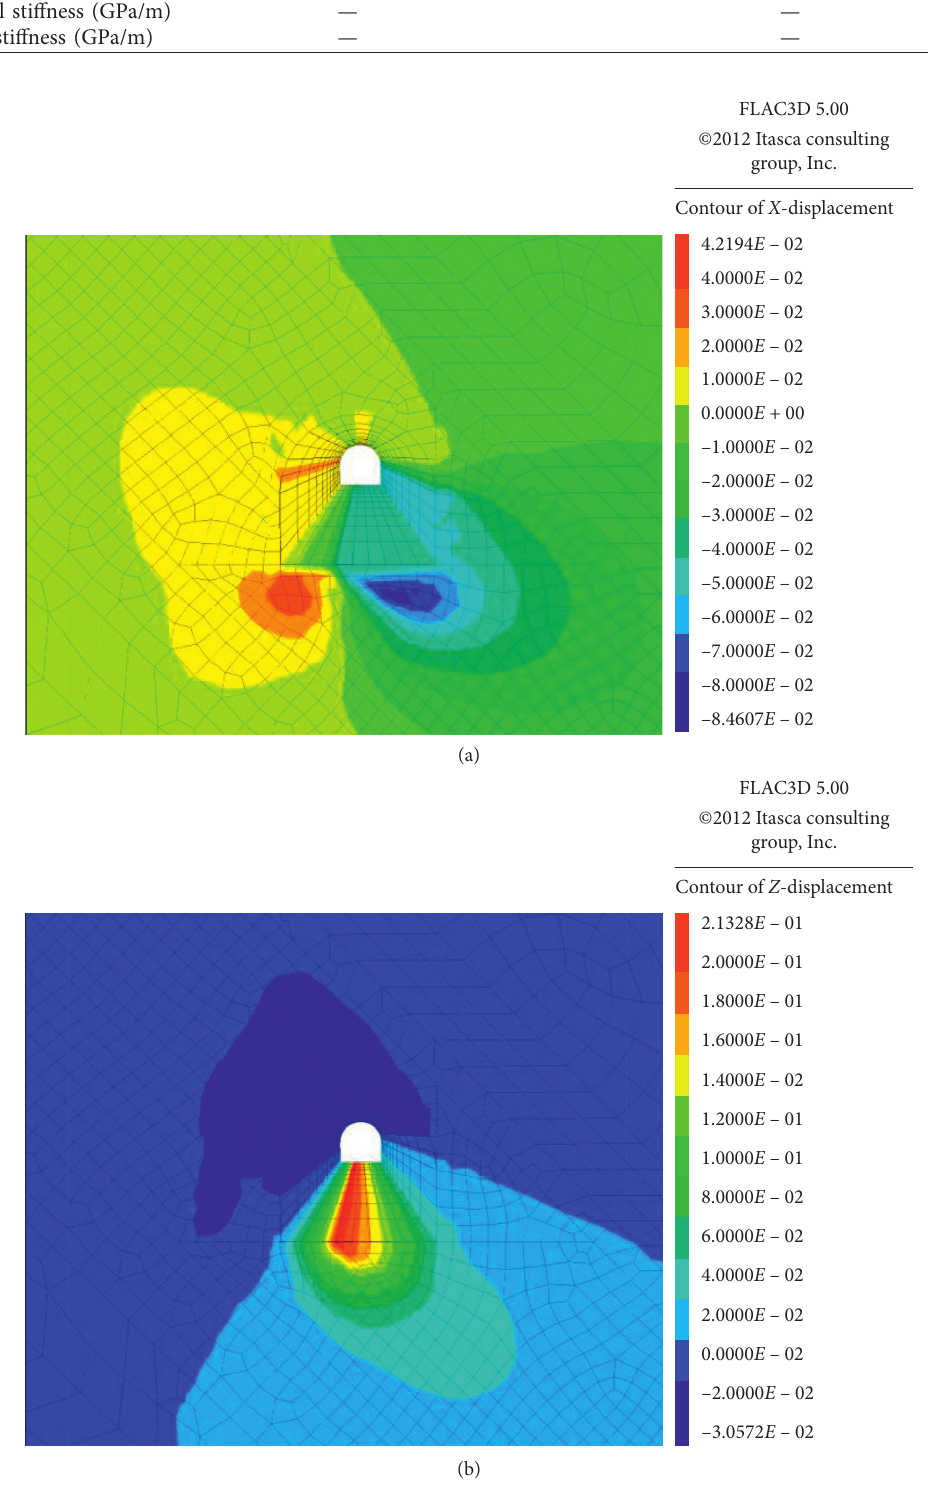
Figure 11: Nephogram of displacement of roadway surrounding rock: (a) horizontal displacement; (b) vertical displacement.